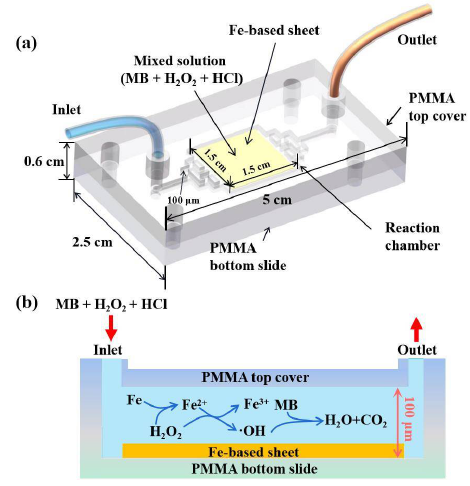
Figure 1. The diagrammatic sketch of the optofluidic Fenton microreactor; ( a ) the 3D structural diagram; ( b ) the cross-section and the reaction pathway.